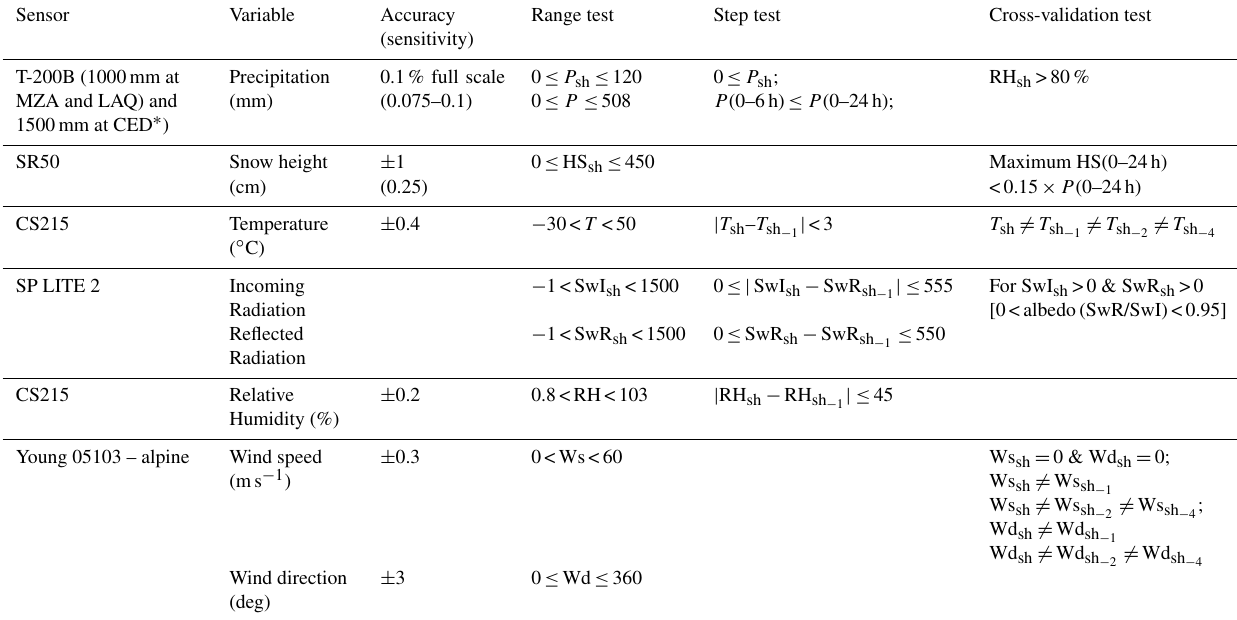
Table 3. Sensor specifications and quality control checks for semi-hourly and daily data – adopted after Estévez et al. (2011) and WMO